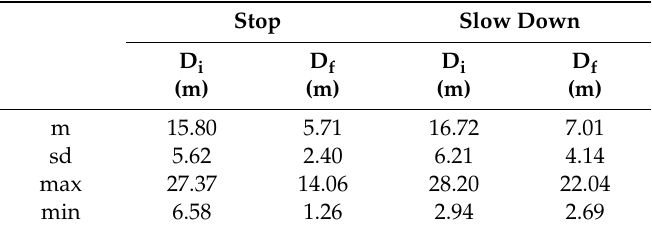
Table 1. Mean, maximum, minimum, and standard deviation of vehicle distance to the crosswalk for stop and slow down movement patterns.